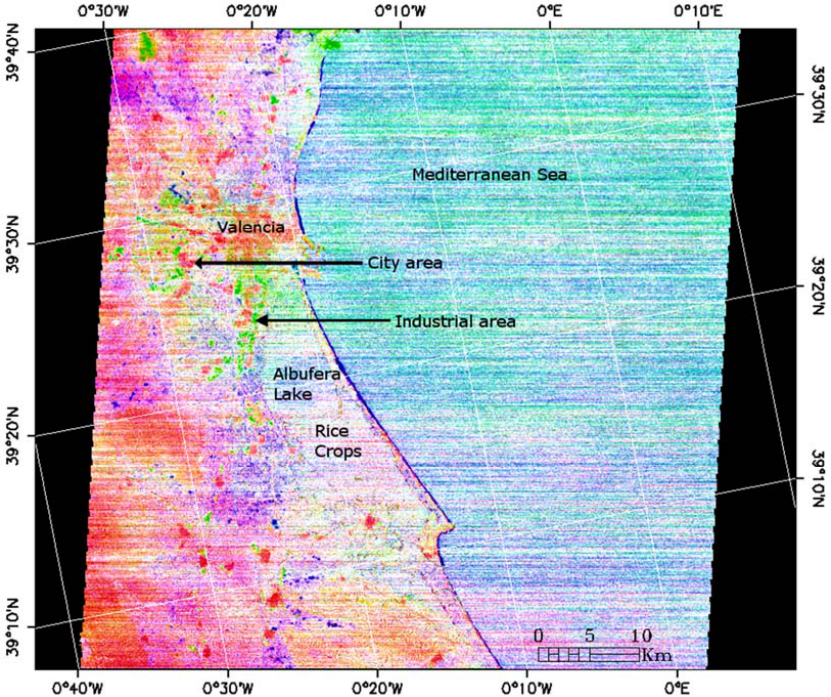
Figure 10. Scene over the study area on 3 August 2004 using TES emissivity from ASTER Channels 10 (8.29 µ m), 12 (9.08 µ m) and 14 (11.32 µ m) to compose the RGB image,